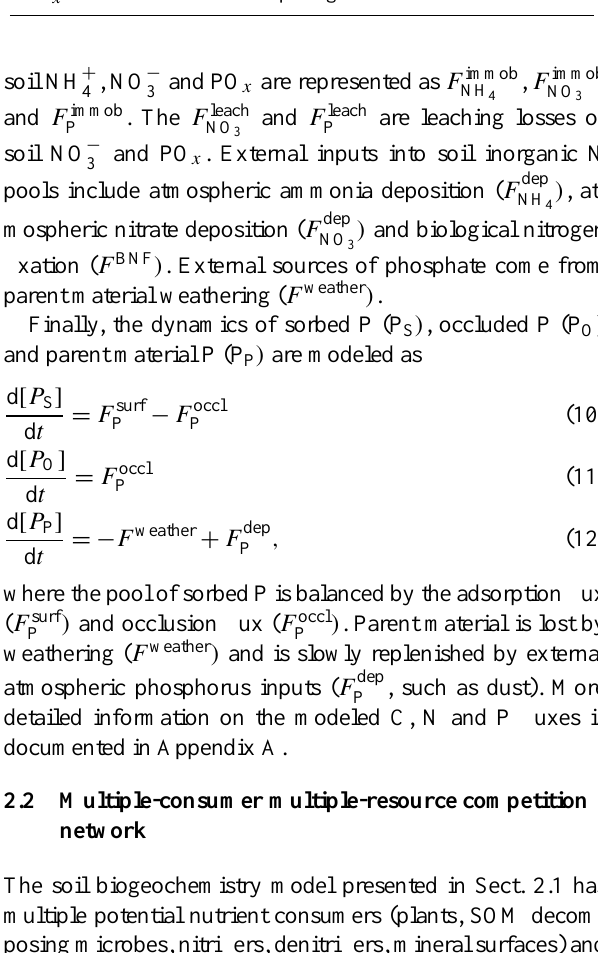
Table 1. A summary of the modeled consumer–resource competi- tion network. Resources Consumers NH + Plant Decomposing microbe Nitrifier 4 NO − Plant Decomposing microbe Denitrifier 3 PO x Plant Decomposing microbe Mineral